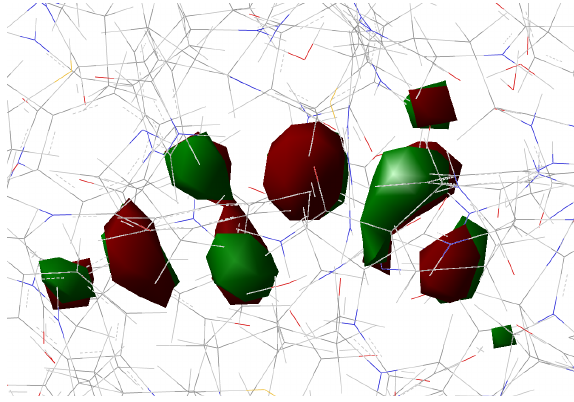
Figure 10. HOMO calculated for psamFP488 in Network1.